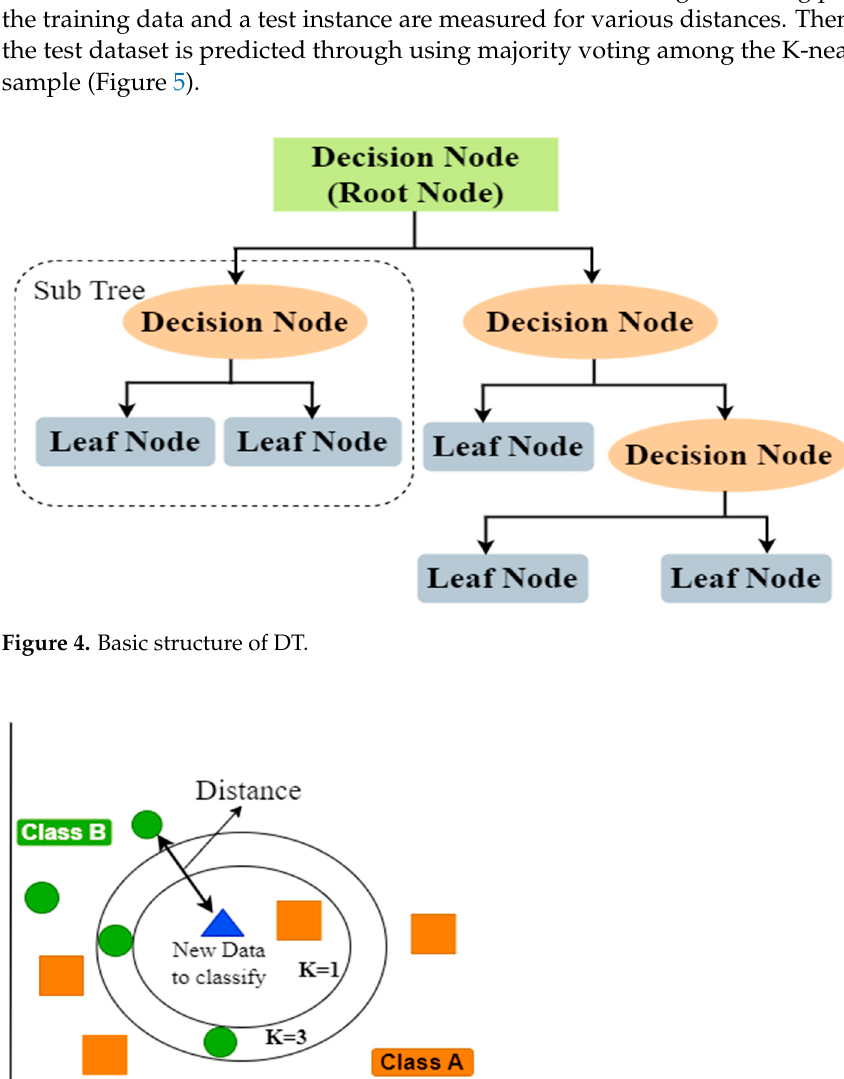
Figure 3. Basic structure of SVM.